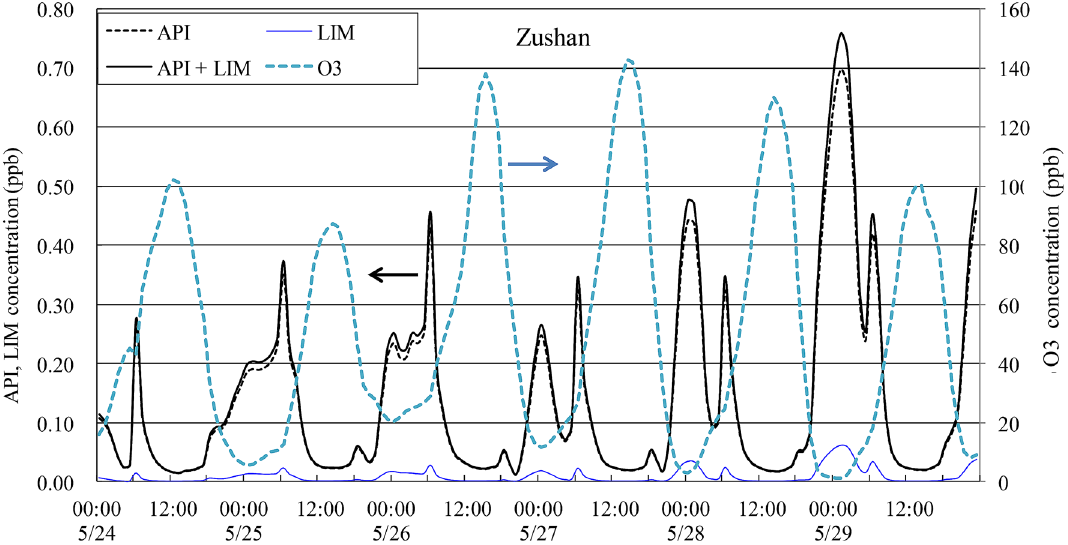
Figure 7. Time series of the simulated API, LIM and O 3 concentrations during the 6-d period from May 24 to 29, 2003, at